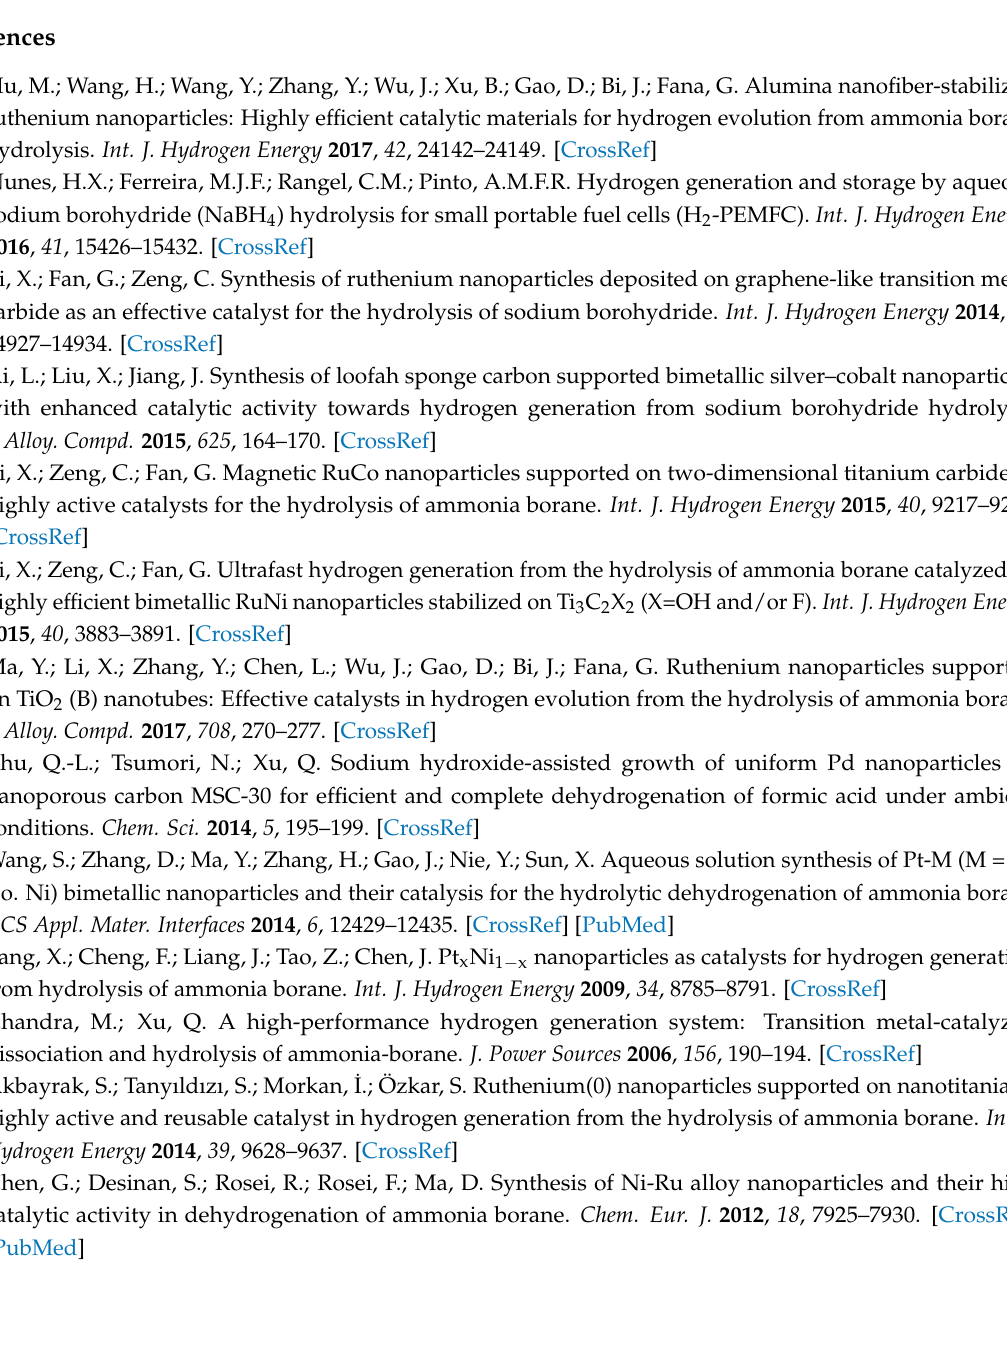
s1. Figure S1: the XRD patterns of the g-C 3 N 4 and Ag X Co 1 − X /g-C 3 N 4 , Figure S2: (a) the TEM image of Ag 0.1 Co 0.9 /g-C 3 N 4 after five recycling runs. (b) Particle size distribution of Ag nanoparticles after 5 recycling runs. (c) Particle size distribution of Co nanoparticles after 5 recycling runs, Table S1: Ag and Co loadings determined by